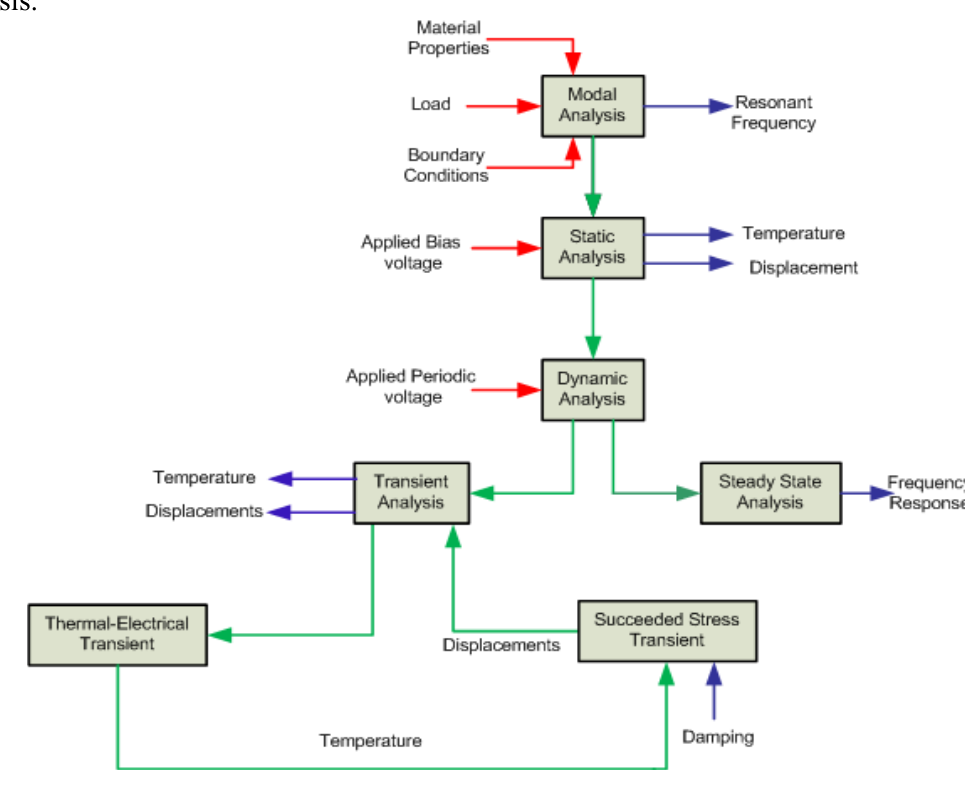
Figure 11. FEM methodology for sequential thermoelectromechanical analysis. Red arrows show the input parameters whereas blue arrows show the output of the respective analysis.